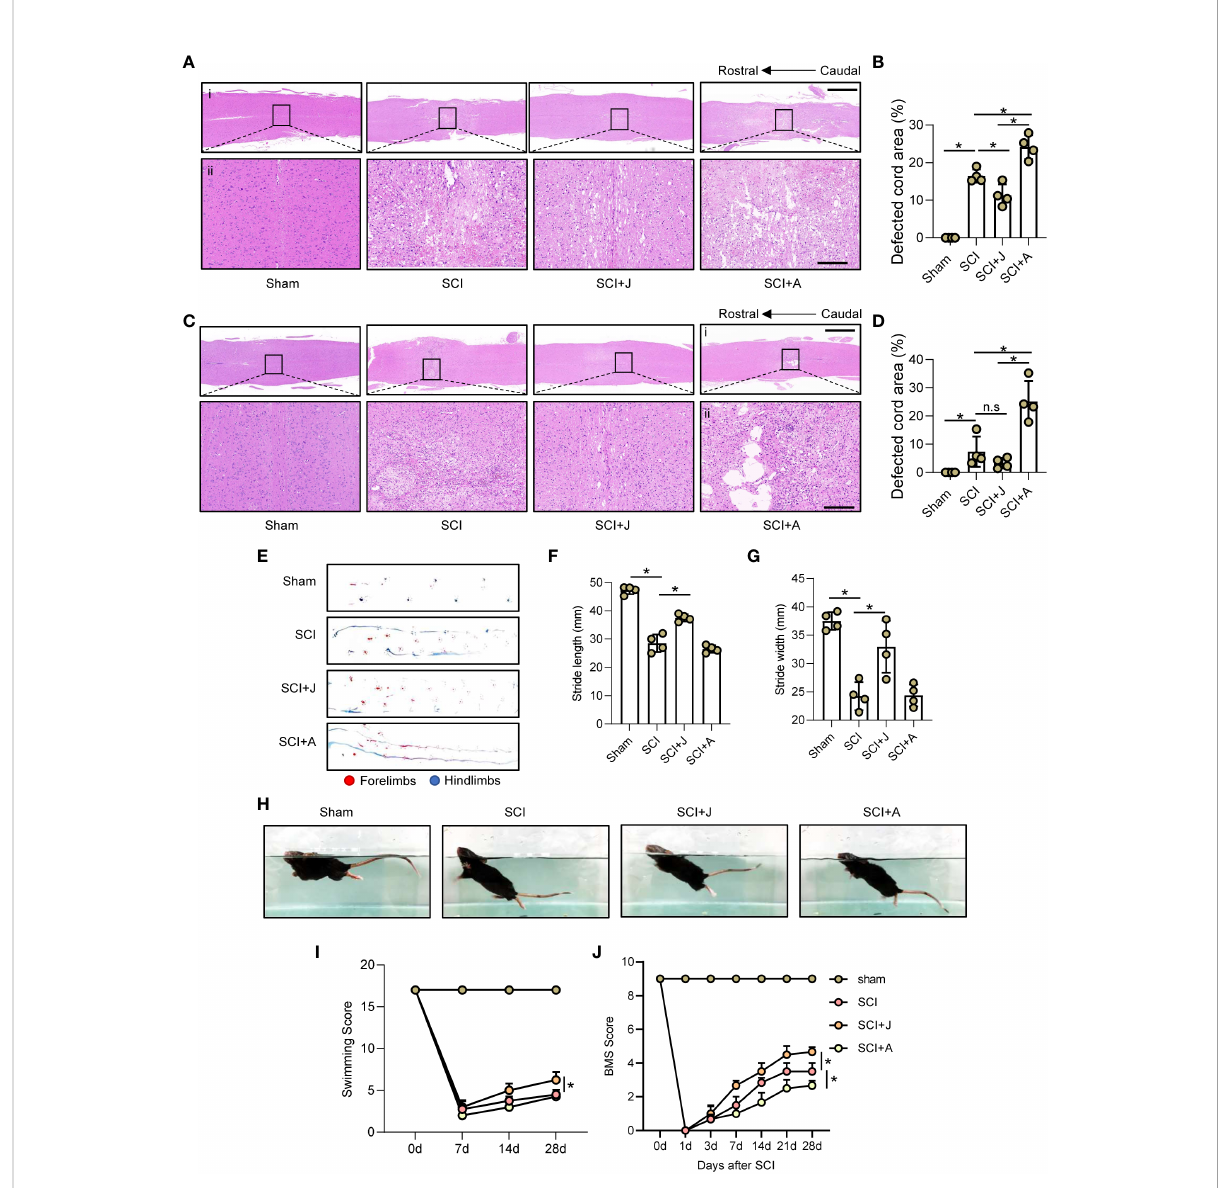
FIGURE 7 CB2R attenuated histological and functional damage post-SCI. (A) Representative images of H&E staining of spinal cords on day 3 post-SCI (injured cords in black frames). Scale bar (i) = 600 m m (ii) = 100 m m. (B) Quantitative analysis of defected area by H&E staining. (C) H&E staining of spinal cords on day 3 post-SCI (injured cords in black frames). Scale bar: (i) = 600 m m, (ii) = 100 m m. (D) Quantitative analysis of defected area by H&E staining. (E) Mouse footprint assay on day 28 post-SCI. Quantitative analysis of stride length (F) and width (G) of the hindlimbs of mice post-SCI. (H) Representative images of a mouse swimming on day 28 post-SCI. Statistical analysis of the Louisville Swim Scale score (I) and Basso Mouse Scale (J) over a 28-day period. * p < 0.05. n.s means no signi fi